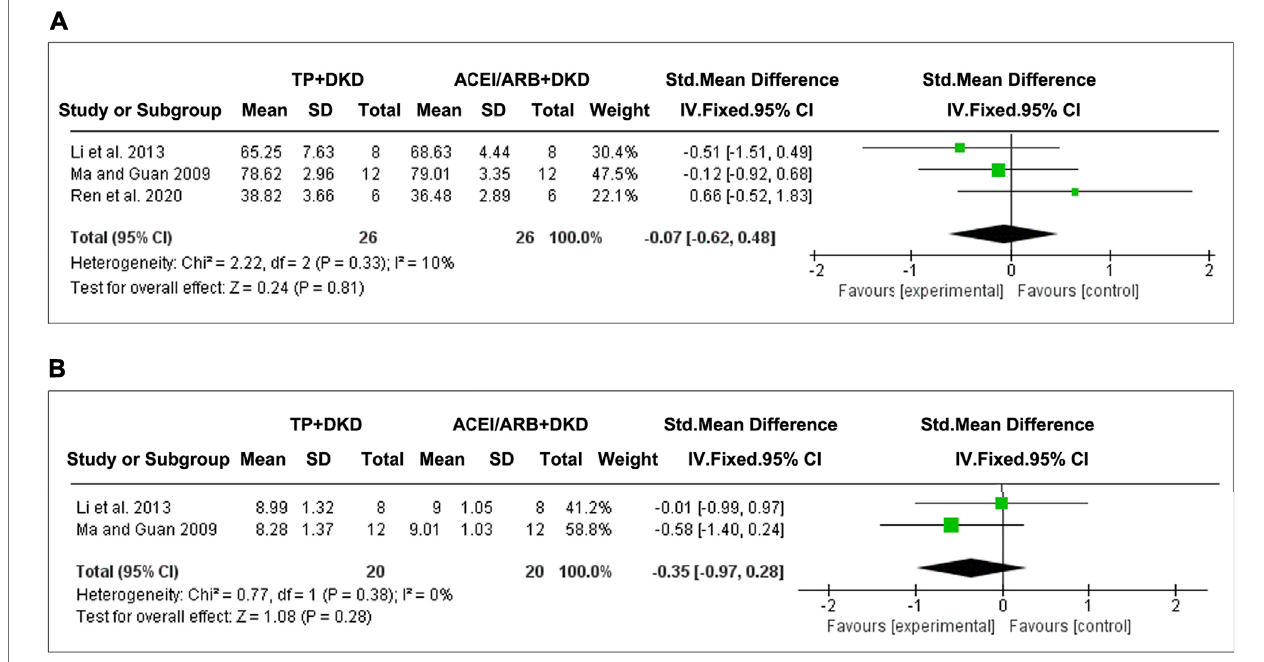
FIGURE 10 | Forest plots of (A) SCr and (B) BUN outcomes compared with RAS inhibitors.